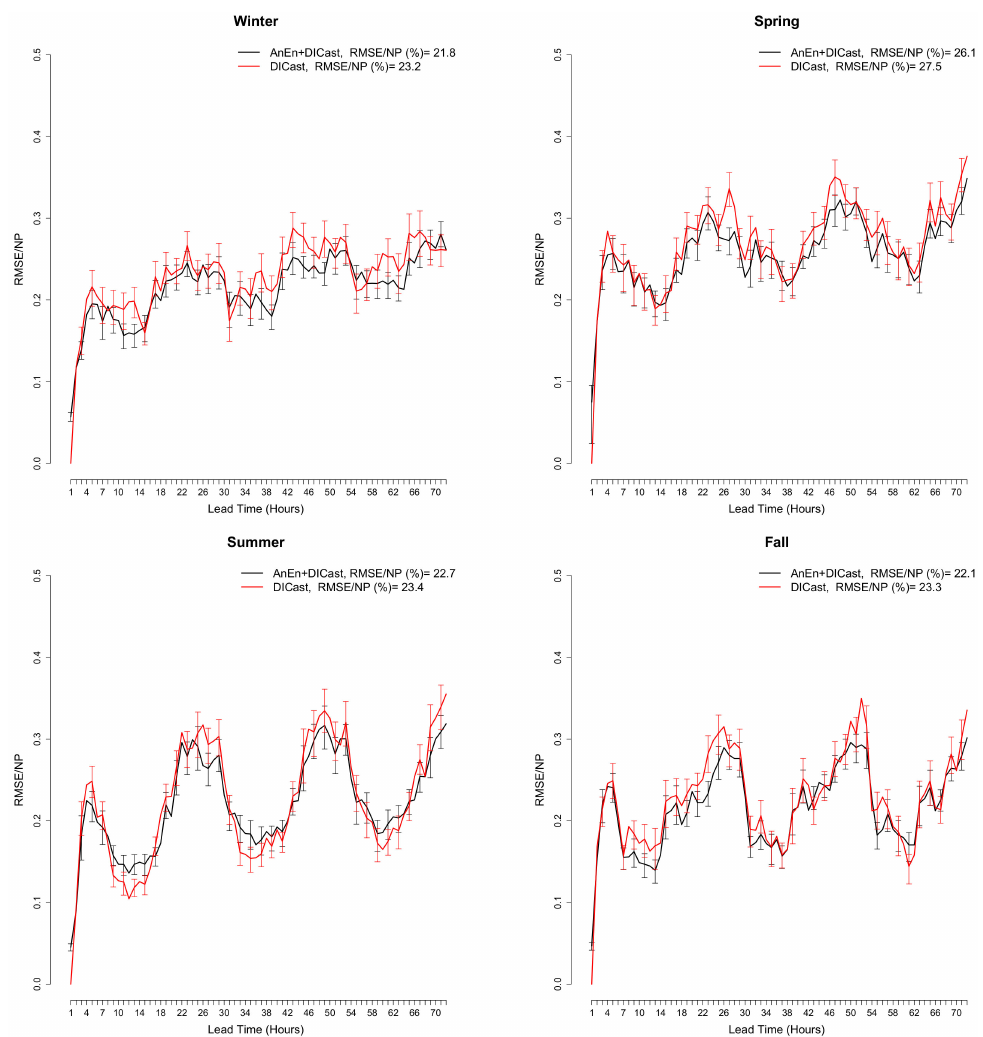
Figure 15. As Figure 13, but for wind power only with data stratified by